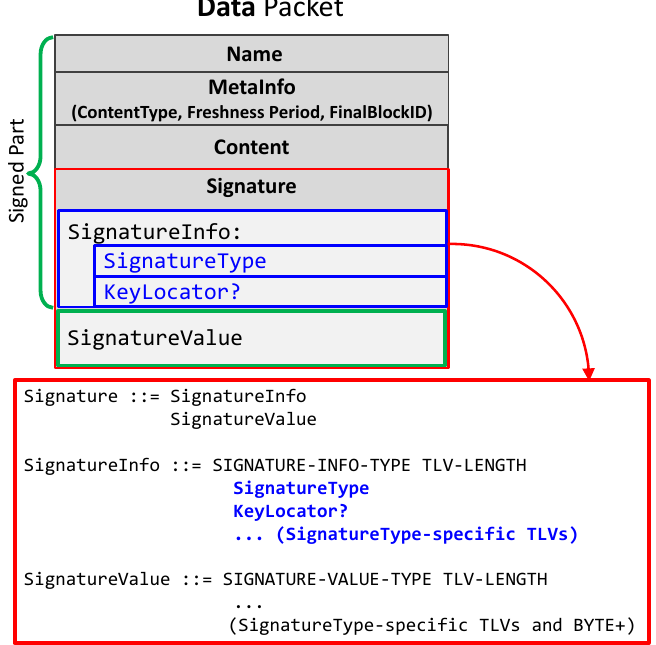
Figure 1. Format of NDN data packets